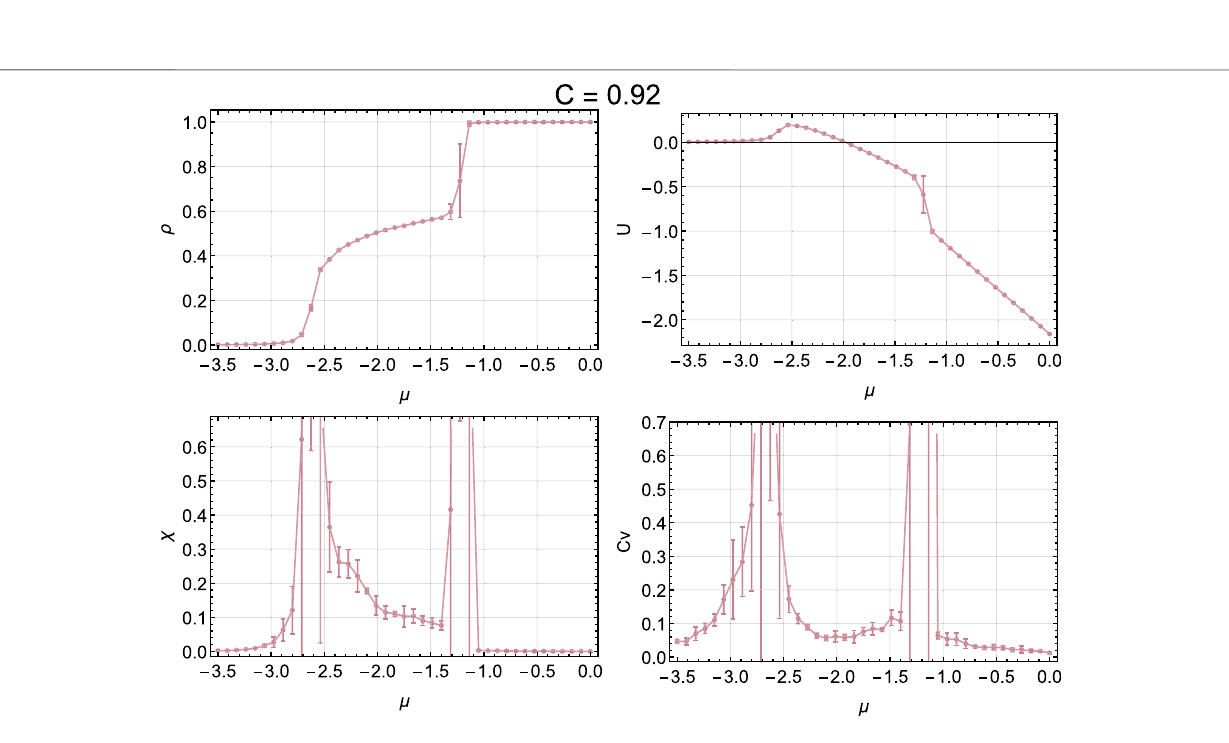
Frontiers in Physics |